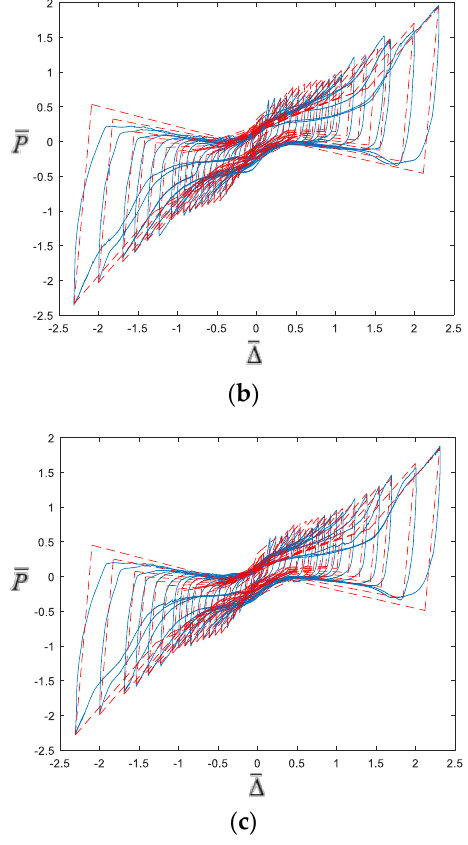
Figure 20. Comparison between the calculation results and the experimental results: ( a ) first displacement cycle; ( b ) second displacement cycle; ( c ) third displacement cycle.